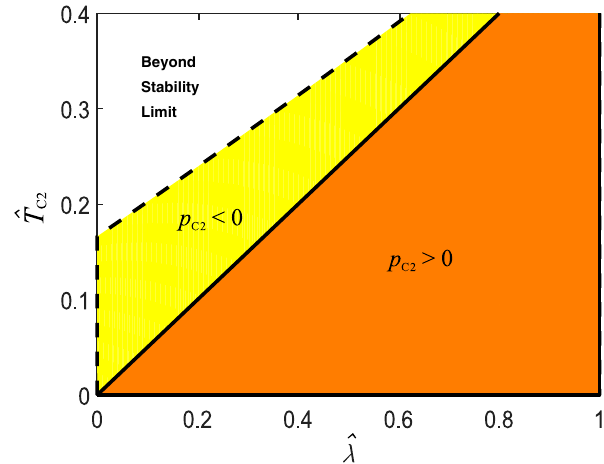
FIG. 3. Parametrized phase diagram for polyamorphic lattice gas in terms of nonideality of mixing of the alternative states A ˆ T ¼ ω = 2 kT and B , c 2 c 1 , and the energy difference of ˆ λ ¼ λ =kT c 1 . The volume difference of states constant. The singularity-free scenario corresponds to The critical-point-free scenario is favored by stronger nonideality and smaller energy